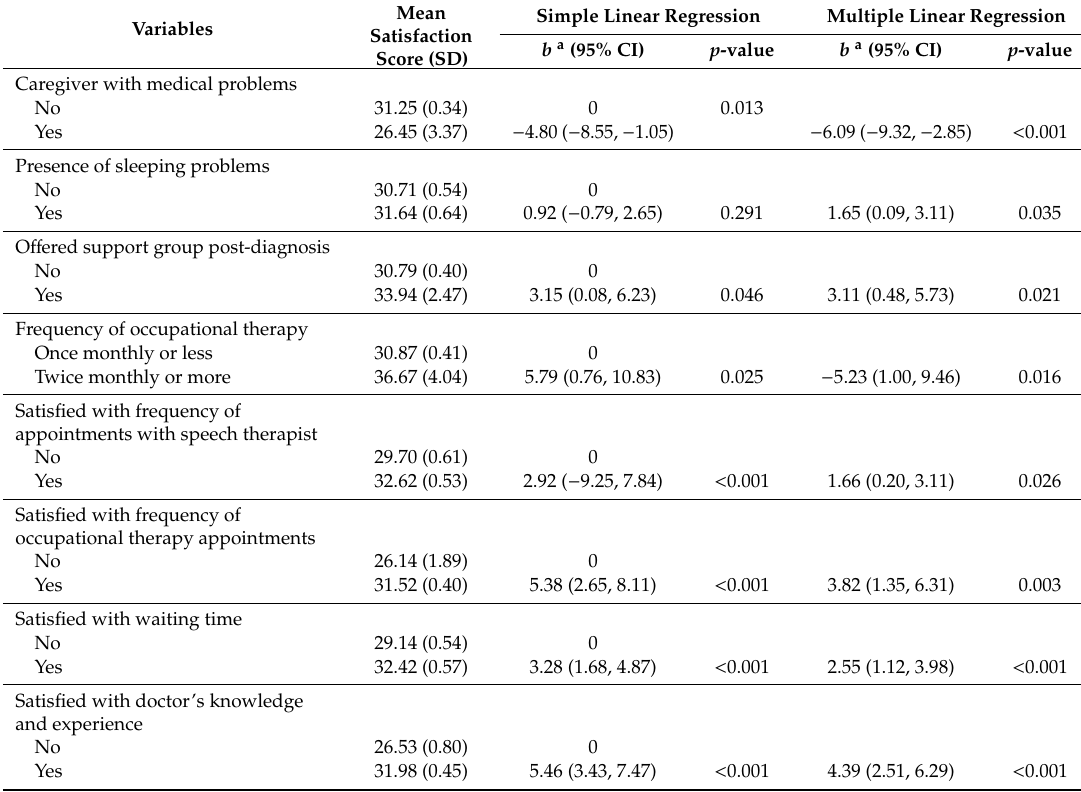
Table 6. Predictors of caregivers’ satisfaction with the health care management of children with ASD at tertiary care ( n = 227). Mean Simple Linear Regression Multiple Linear Regression Variables Satisfaction b a (95% CI) p -value b a (95% CI) p -value Score (SD) 31.25 (0.34) 0 0.013 Yes − 4.80 ( − 8.55, − 1.05) − 6.09 ( − 9.32, − 2.85) <